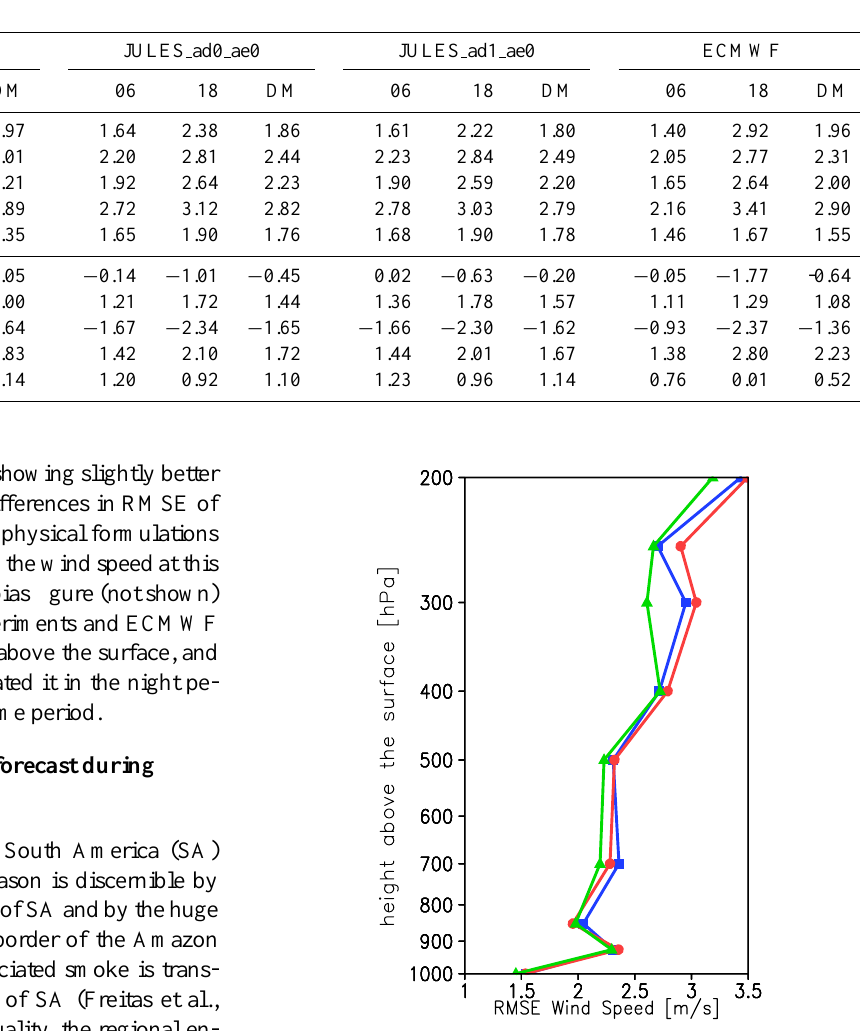
Fig. 5. Root-mean-squared error of wind speed, considering ra- diosounding data measured daily at 12Z at 11 stations, during the 31 days of the month of March 2010.